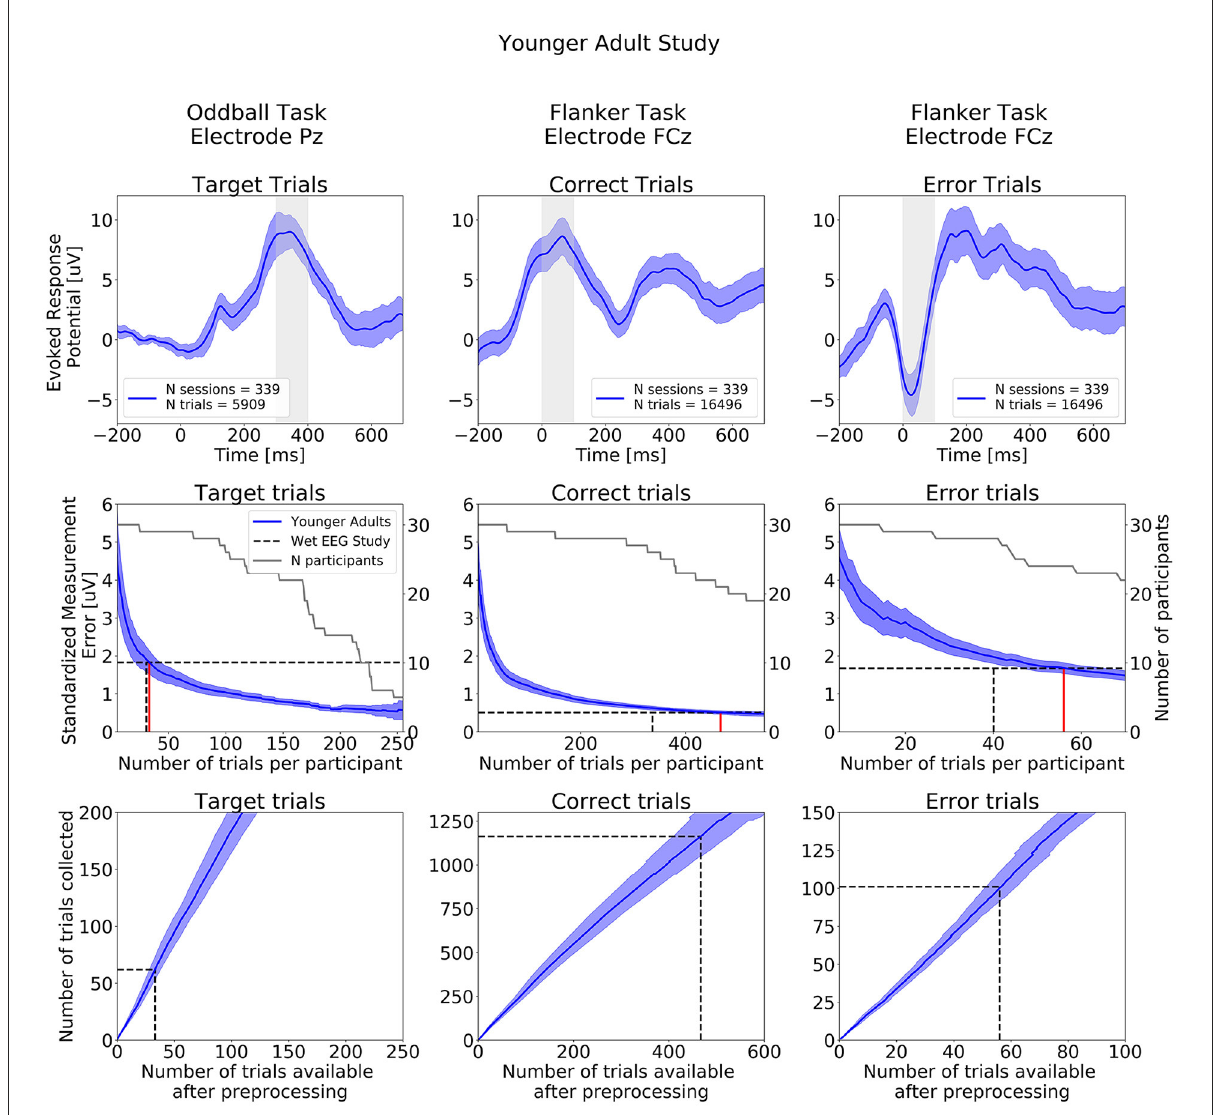
FIGURE7 ERPs analyses extracted from the Younger Adult Study ( N 30). Top row: Grand study average computed across all participants. Middle row: = Standardized Measurement Errors per number of trials. The gray continuous lines correspond to the number of participants remaining in the SME calculation after trial rejection. Bottom Row: Mean numbers of trials available after preprocessing. The black dotted lines correspond to the mean numbers of trials extracted from the wet EEG study. From left to right: Target Trials extracted from the Oddball task at electrode Pz, Correct Trials extracted from the Flanker task at electrode FCz, Error Trials extracted from the Flanker task at electrode FCz. The shaded areas correspond to the 95% confidence